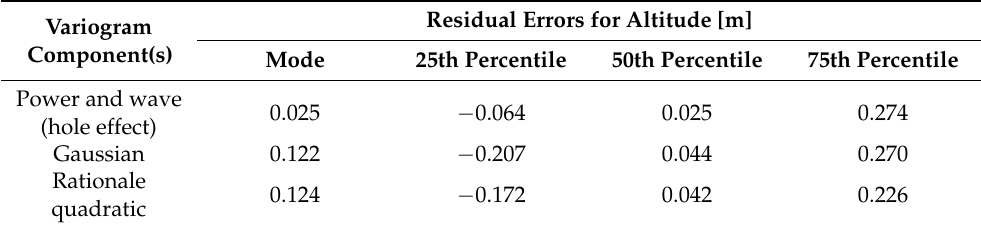
Table A3. Statistics of the residual errors of the tested variogram components.